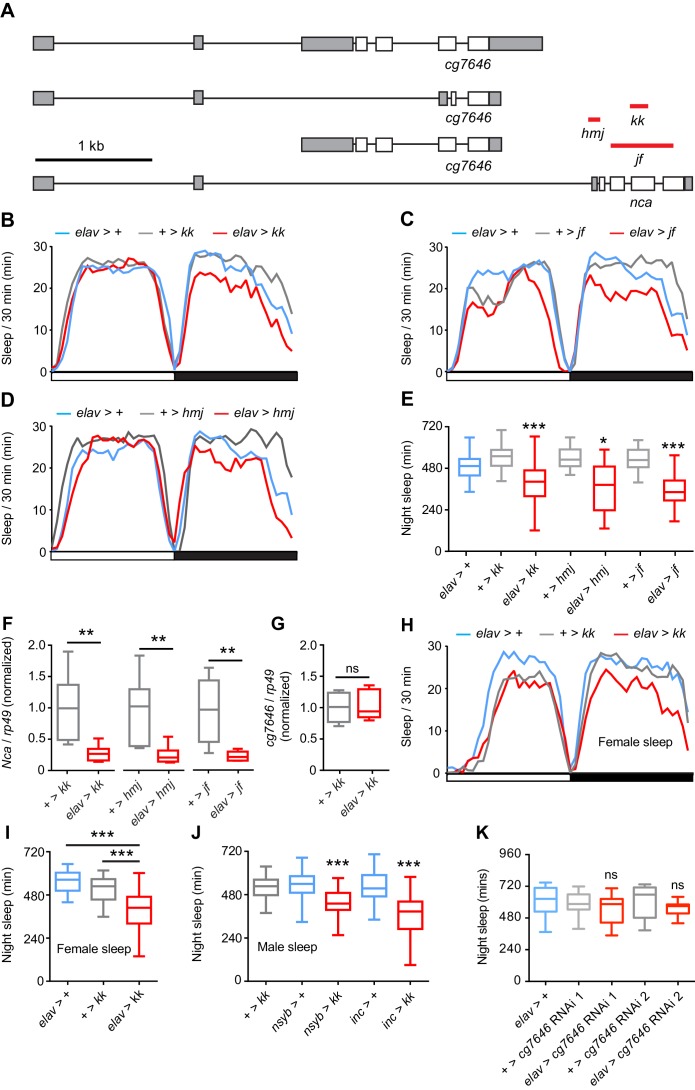
Pan-neuronal knockdown of Nca using independent RNAi lines causes night sleep loss.(A) Schematic showing transcripts derived from the Nca locus alongside transcripts derived from the cg7646 locus, which shares common 5’ untranslated regions with Nca. Regions of Nca mRNA targeted by the kk108825, hmj21533 and jf03398 RNAi lines (termed kk, hmj and jf respectively) are shown as red bars. (B–D) Mean sleep levels measured using the DAM system under 12L: 12D conditions for male adult pan-neuronal Nca knockdown flies (B: elav > kk, C: elav > jf; D: elav > hmj) and associated controls (elav-Gal4 driver or RNAi transgene heterozygotes). n = 17–48. (E) Median sleep levels in the above genotypes. Night sleep is significantly reduced in all knockdown backgrounds compared to both transgene and driver alone controls. (F) qPCR verification of Nca knockdown by the kk, hmj and jf RNAi constructs. Transgene insertions lacking the elav-Gal4 driver were used as controls. (G) Knockdown of Nca had no effect on expression of cg7646. Expression levels of Nca or cg7646 were normalised to the ribosomal protein 49 (rp49) control transcript and are displayed as the ratio to the mean level of the respective RNAi alone controls (+ > kk, + > hmj or + > jf). n = 6–9 for all qPCRs (2–3 independent biological repetitions of RNA extraction with triplicated qPCR reactions for each genotype). (H–I) Pan-neuronal Nca knockdown in adult Drosophila females reduces night sleep. Mean sleep patterns of NcaKD females and associated controls in 12L: 12D conditions are shown in (H). Median night sleep levels are shown in (I). Day sleep levels are unaffected relative to heterozygous kk RNAi insertion controls (H). n = 31–32. (J) Pan-neuronal or broad Nca knockdown in adult males using either nsyb- or insomniac (inc)-Gal4 also reduced total night sleep levels in 12L: 12D conditions compared to both transgene and driver alone controls. n = 38–53. (K) Pan-neuronal expression of RNAi targeting cg7646 mRNA did not alter night sleep in Drosophila males compared to both transgene and driver alone controls. Two different chromosomal insertions of the same RNAi hairpin were used (RNAi one and RNAi 2). n = 12–15. ns - p>0.05, *p<0.05, **p<0.01, ***p<0.001, Kruskal-Wallis test with Dunn’s post-hoc test (E, I, J, K) or Mann-Whitney U-test (F, G).